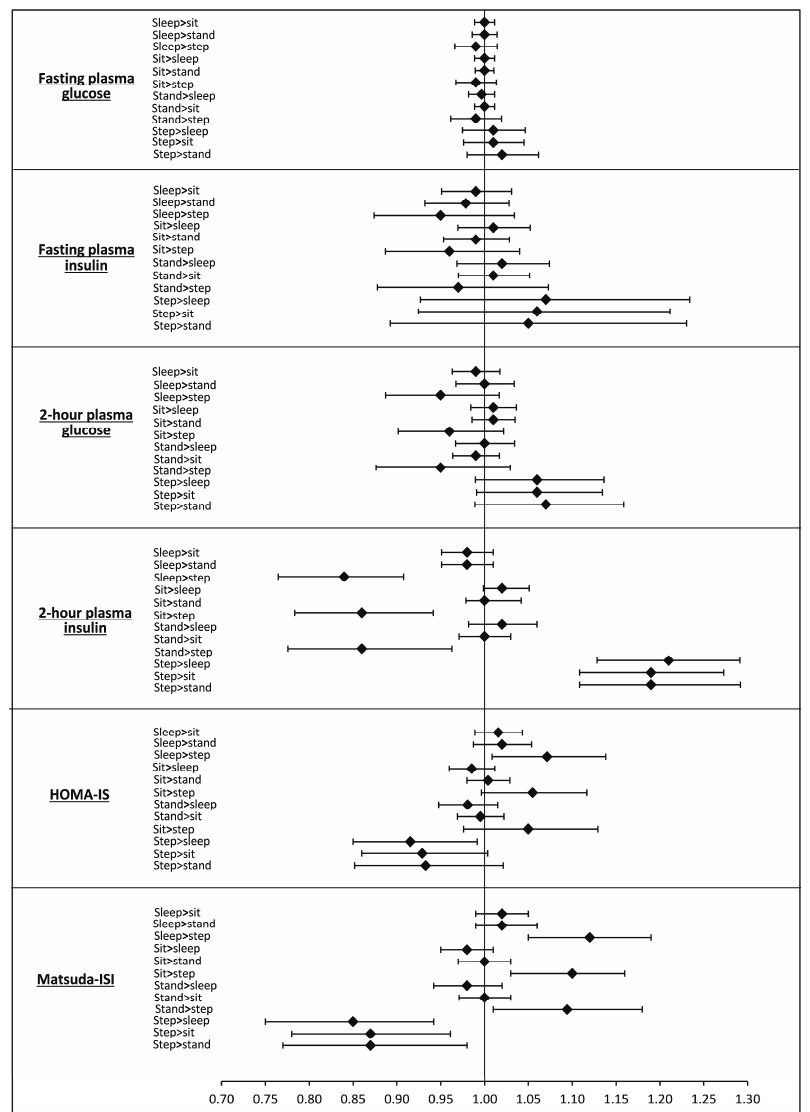
Figure 1. Fold difference (95% CI) per 30 min/day reallocation. Adjusted for age, sex, ethnicity, smoking status, β -blocker use, statin use, family history of diabetes, and BMI (Model 2 only).